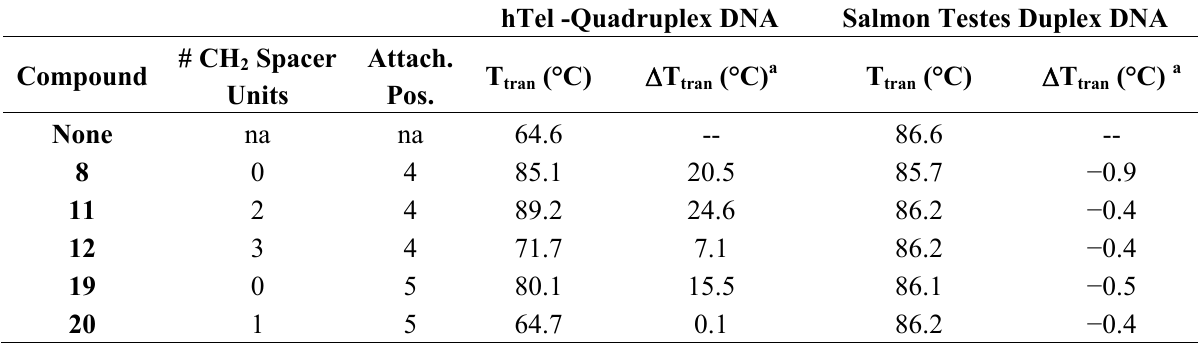
Table 1. Effect of various pyridyl polyoxazoles on the thermal stabilities of duplex and quadruplex